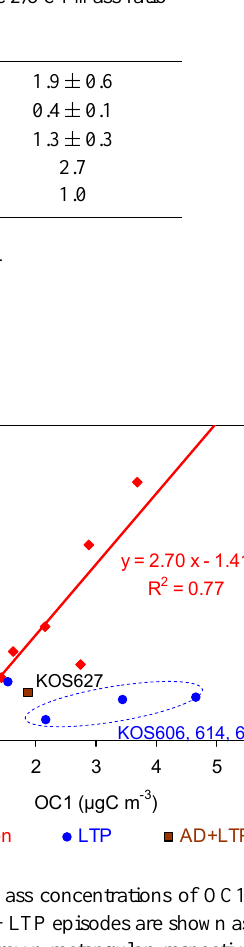
Table 4. Average mass fractions of OC evolved at each temperature step in total OC and OC2/OC1 mass ratios according to categorized carbon episodes. The mass fraction in total OC [%] Category